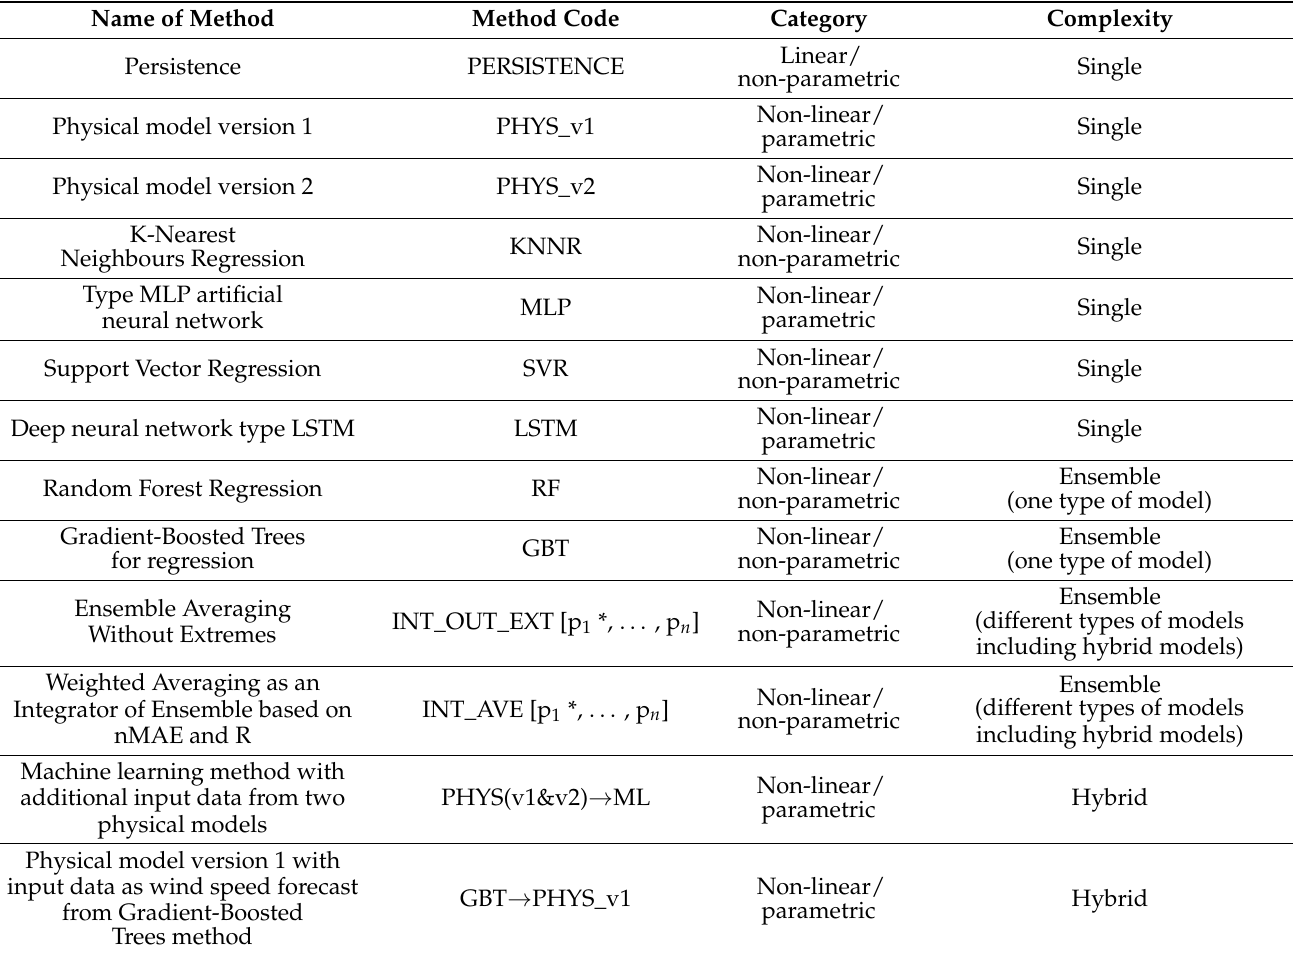
Table 4. Summary description of thirteen tested forecasting methods.